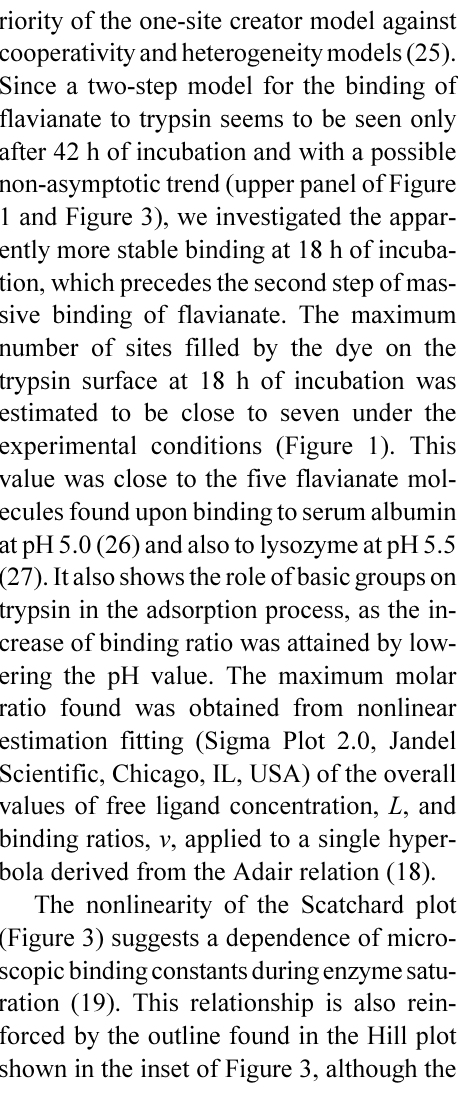
Figure 3. Scatchard representa- tion of the binding of flavianic acid to trypsin at 18 h of incuba- tion. The line was fitted to the heterogeneity model with bind- ing constants calculated accord- ing to the deconvolution method of Schreier and Schimmel (31). Inset : Hill plot of the data. The lines represent values calculated by linear regressions applied to the two population sites filled by flavianate (see